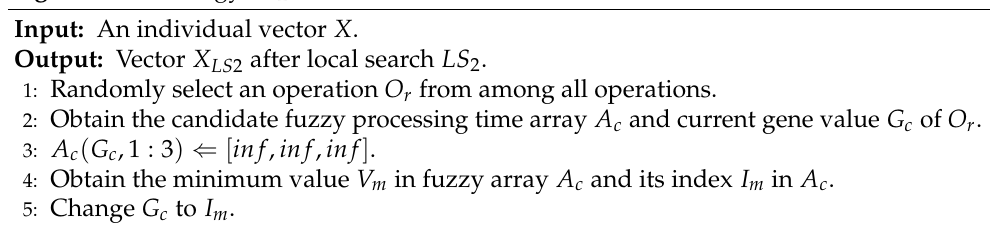
Algorithm 5 Strategy LS 2